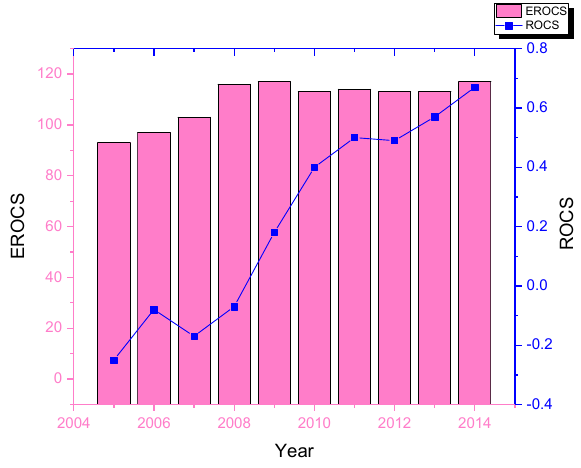
Figure 4. Dynamics of indicators of ROCS and EROCS.